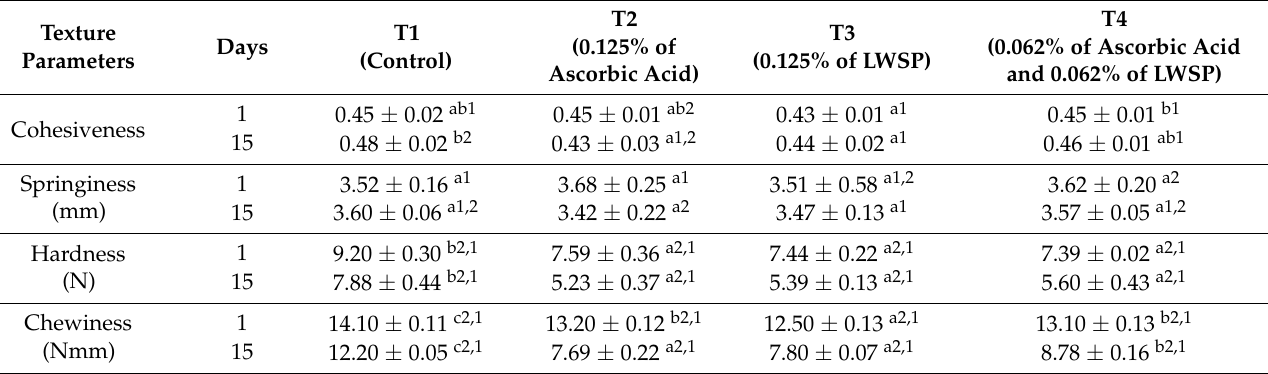
Table 1. Texture profile analysis of sausages during refrigerated